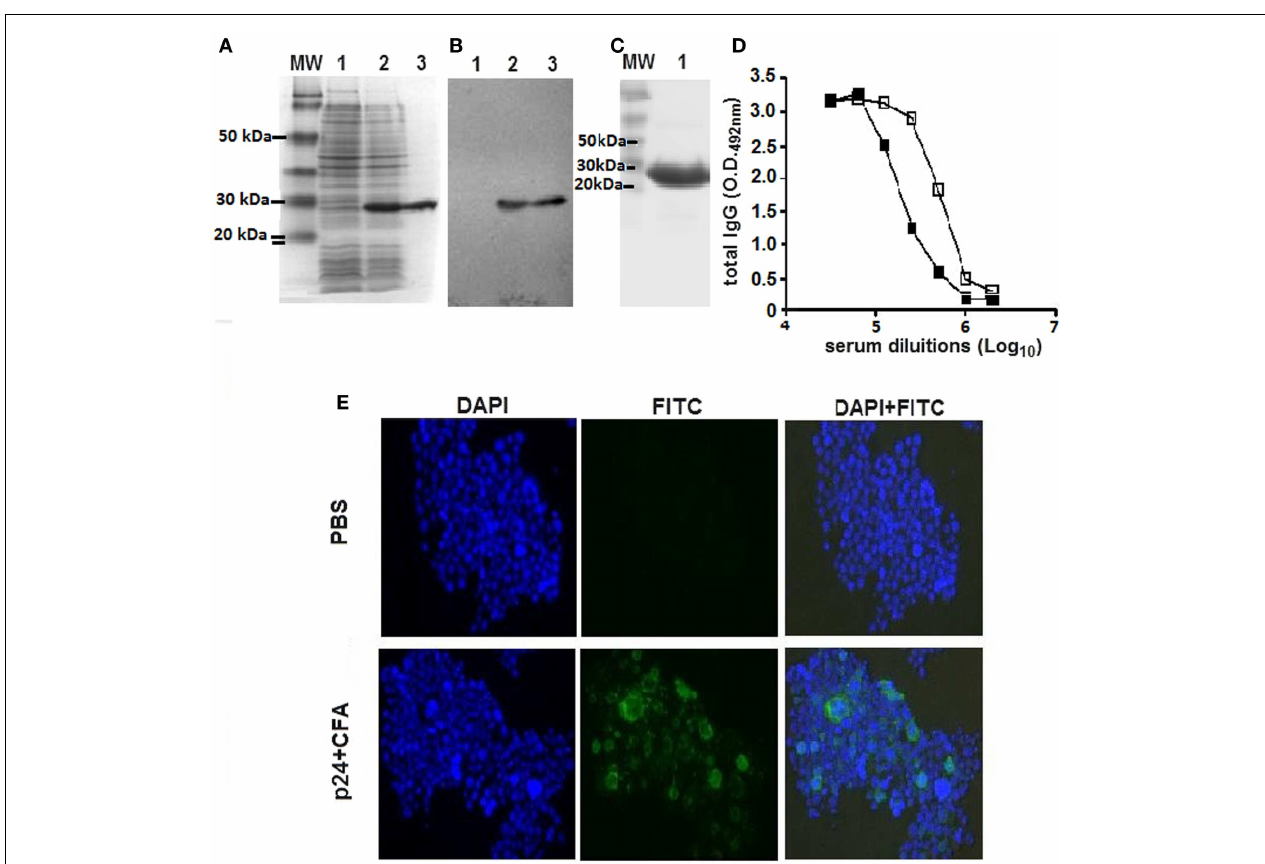
as described above. (C) SDS-PAGE analysis of purified p24 protein not completely separated on 15% polyacrylamide gels. (D) Antigenicity of the recombinant p24.The protein was employed as solid phase-bound antigen in ELISA plates developed with sera obtained from an HIV-1 infected subject (open squares) or from a rabbit immunized with recombinant p24 (closed squares). (E) Antibodies raised in mice immunized with the recombinant p24 recognize the native viral protein. Cells of the A3.01 lineage were transfected with the pHXB2 vector encoding the complete HIV-1 genome. After 7days, the cells were fixed and incubated with serum from mice immunized with p24 combined with Freund’s adjuvant (lower panel series) or PBS (upper panel series), at a final dilution of 1:500. Cells were labeled with FITC-conjugated anti-mouse IgG antibody and DAPI.The experiments were performed twice showing the same